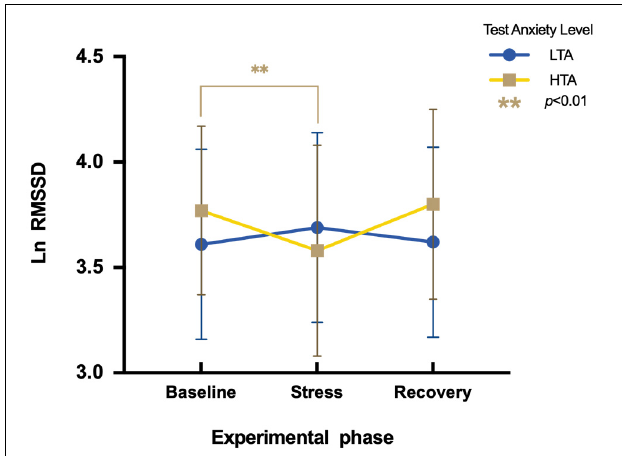
FIGURE 6 | Differences in Ln RMSSD during three experimental phases of HTA and LTA individuals. ∗∗ represents a significant difference between the baseline and stress phase of HTA individuals with p -value < 0.01.